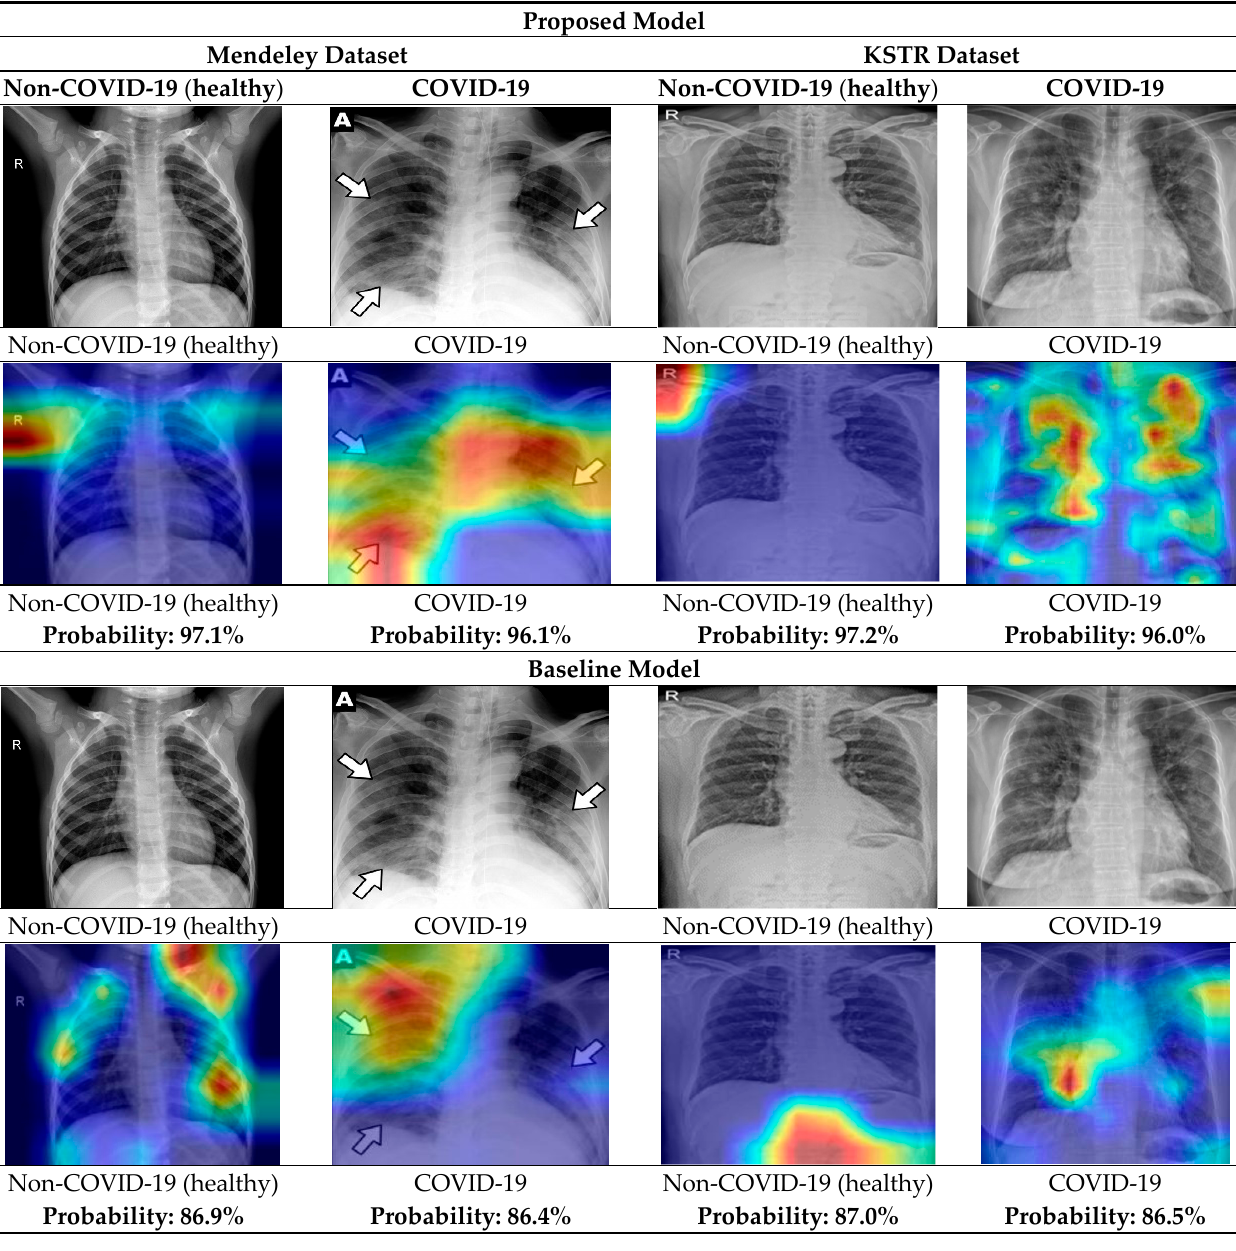
Figure 9. XAI on